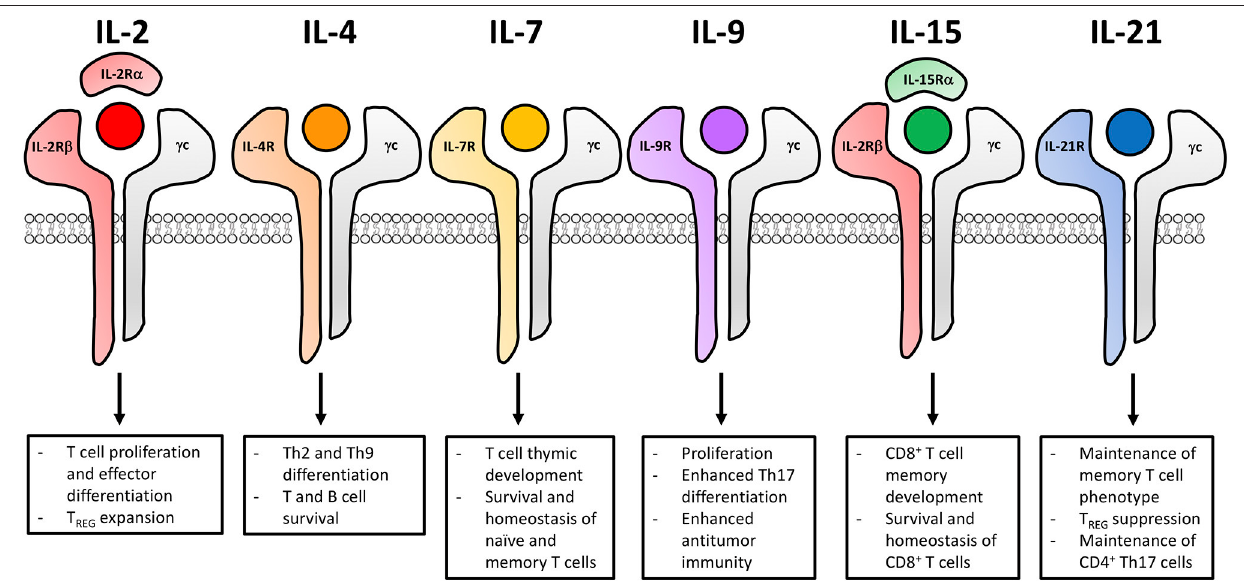
FIGURE 1 | Common γ chain cytokine signaling impacts the functional fate of T cells for adoptive cell transfer. The six members of the γ c cytokine family (IL-2, IL-4, IL-7, IL-9, IL-15, and IL-21) and the composition of their unique cytokine receptors. Signaling cascades from these receptors lead to distinct biological outcomes impacting differentiation, effector function and memory development of T